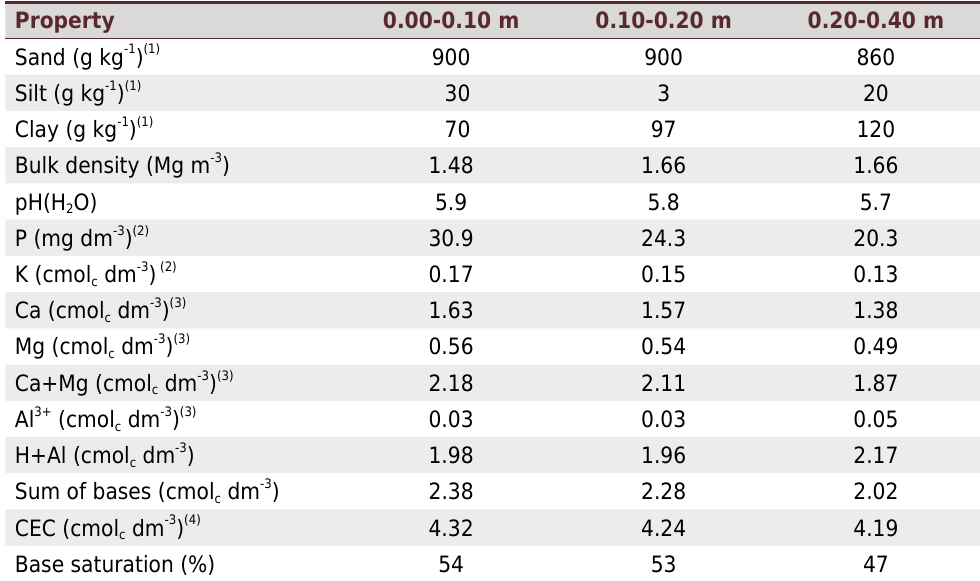
Table 1. Physical and chemical properties of a cohesive Latossolo Amarelo Álico (Haplortox) in the 0.00-0.10, 0.10-0.20 and 0.20-0.40 m layers under orange trees